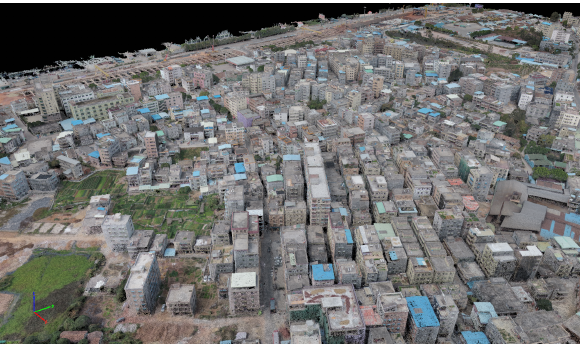
Figure 11: Large data set reconstruction using Pix4Dmapper